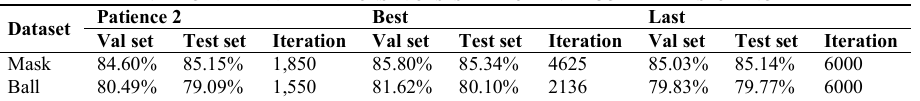
TABLE 11 A VERAGE M AP AND ITERATIONS IN CASES THAT OFTEN TRIGGER EARLY